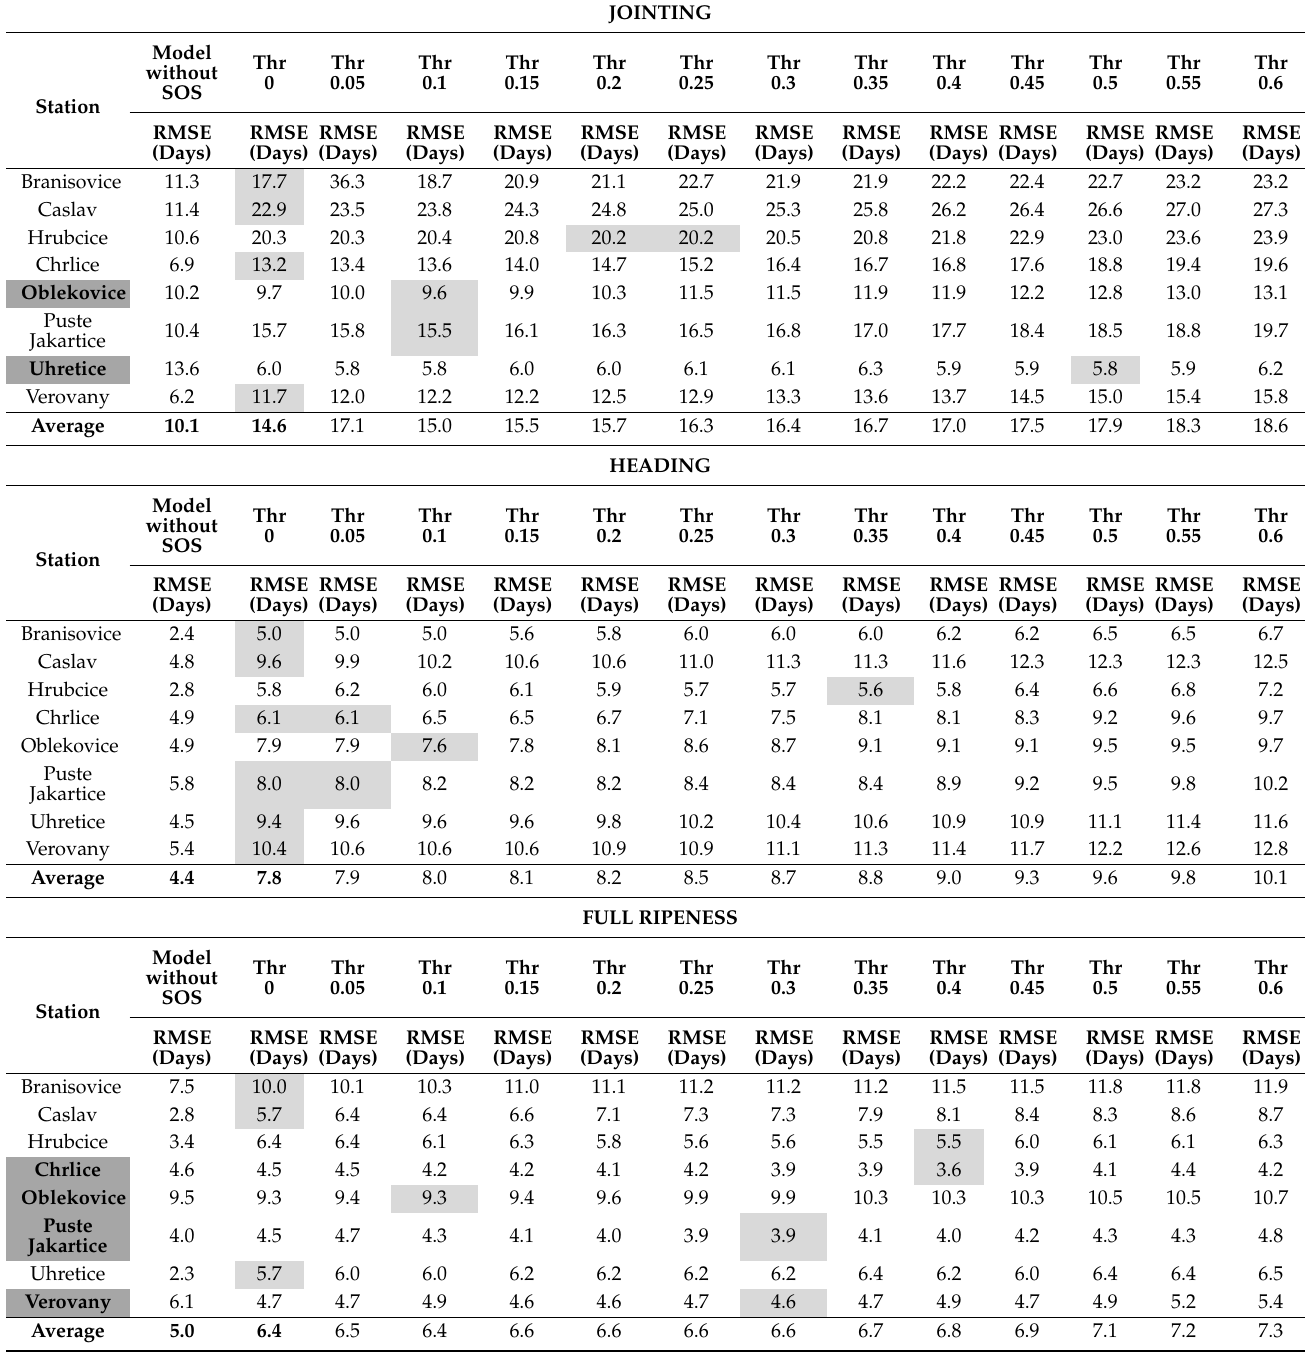
Table A2. The RMSE values describe the accuracy modeled at the onsets of the jointing, heading, and full ripeness phenophases. Thr-0 to Thr-0.6 columns indicated the RMSE values for the modeled onsets of phenophases, including the start of the growing season derived from NDVI. The lowest values for each station are highlighted with a light gray background. A dark gray background highlights the station; the model including SOS is better than the model without